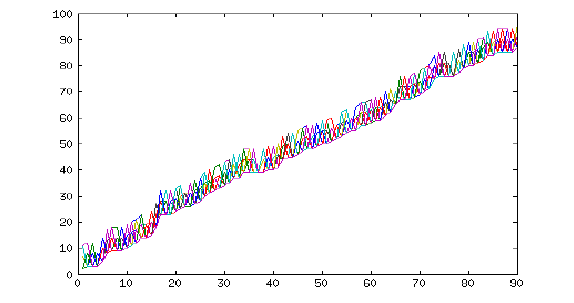
Figure 2. The top alignments between few samples from 2 different classes. Here, X-axis is the length of the samples from class 1 and Y-axis is the length of the samples from class 2.